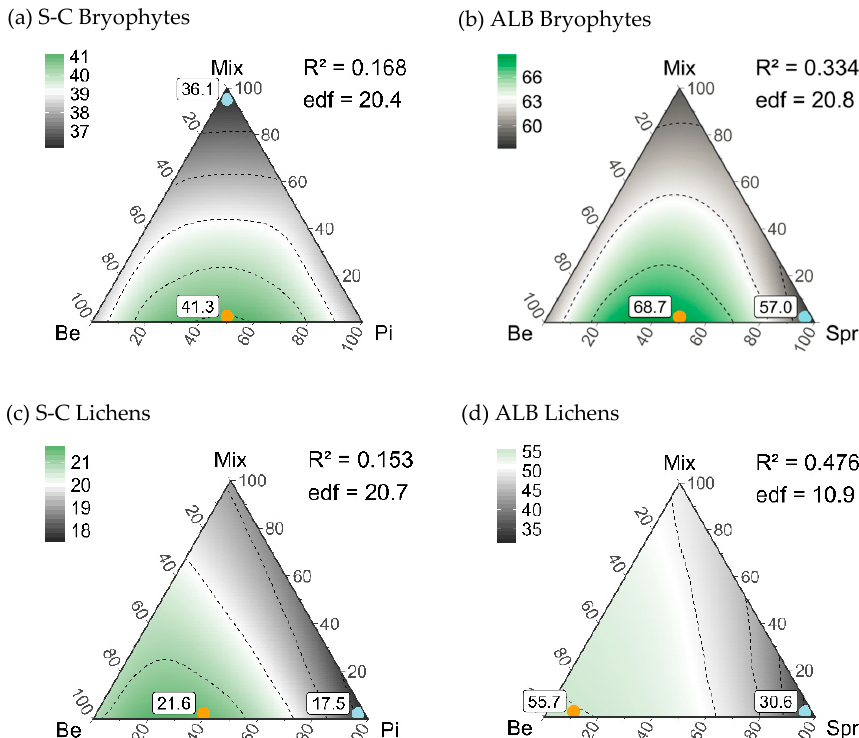
Figure 5. Gamma diversity (species richness) of bryophytes ( a , b ) and lichens ( c , d ) along compositional gradients of pure beech (Be), pure conifer (Pi = Pine, Spr = Spruce) and mixed stands (Mix) in Schorfheide-Chorin (S-C; ( a , c )) and Schwäbische Alb (ALB; ( b , d )). The stand type composition was varied in steps of 10% using 1000 resamplings of 36 (bryophytes S-C), 26 (bryophytes ALB), 22 (lichens S-C) plots per step (66 unique stand type compositions). For lichens of ALB 10 plots out of 12 were resampled for 66 times. The diversity response to stand type composition is characterized by R 2 and estimated degrees of freedom (edf). Labelled dots mark the maximum (orange) and minimum (light blue) gamma diversity.